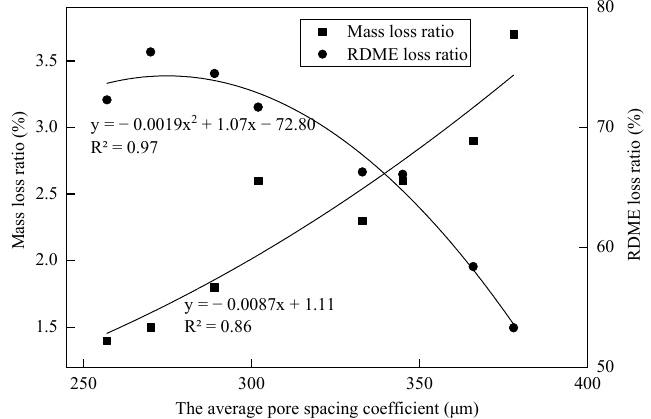
Figure 17. Relationship between average pore spacing coefficient and frost